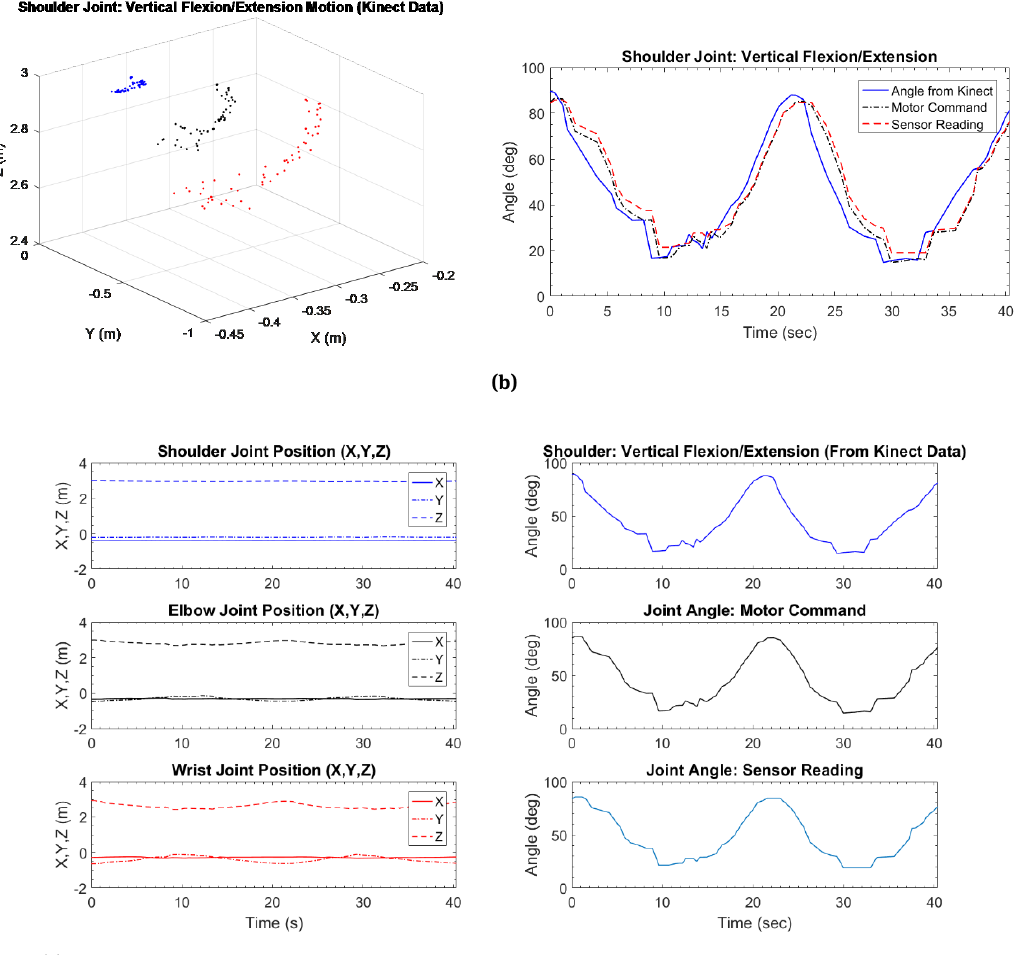
Figure 12: Shoulder joint flexion/extension teleoperation. (a) Shoulder joint flexion/extension teleoperation, (joint coordinate from Kinect). (b) Comparison between joint angles from Kinect and NAO robot. (c) Coordinate data and joint angles from Kinect and NAO robot